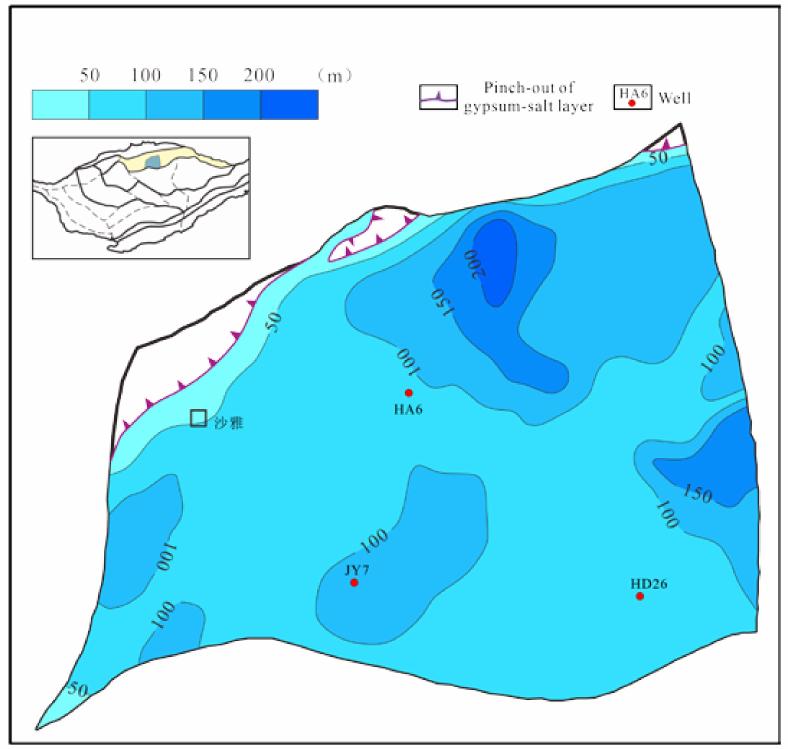
Figure 7. The thickness distribution of the gypsum-salt layer of the Carboniferous strata in Halahatang depression. The gypsum-salt layer distributes in Carboniferous